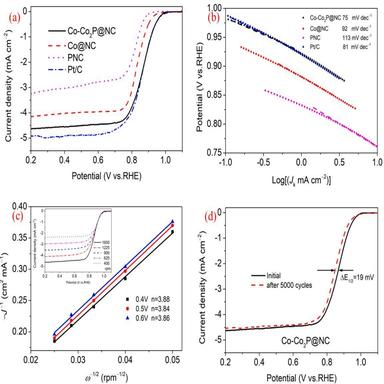
(a) ORR LSV curves of different catalysts and (b) the corresponding Tafel plots; (c) LSV curves of Co-Co2P @ NC at different electrode rotation rates (inset) and K-L plots; (d) Comparison of polarization curves before and after stability test.